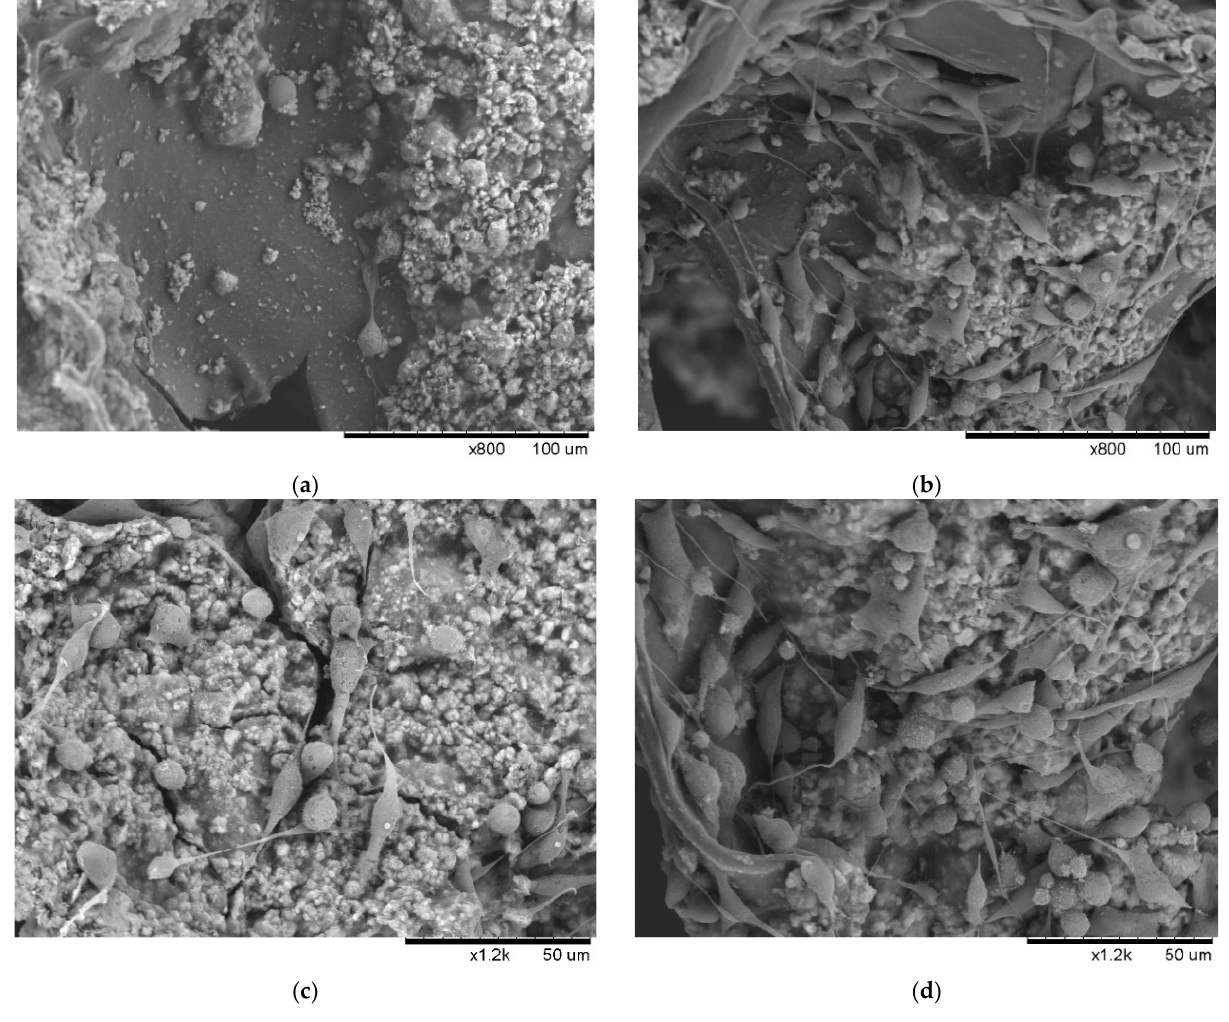
Figure 4. HAp and EGF promoted the adhesion and proliferation of MDA-MB-231: ( a ) on the third day of culture, only a small number of cells were observed to adhere to the smooth surface (gelatin) without EGF; ( b ) cell proliferation for EGF immobilized on the smooth surface (gelatin); ( c ) adhesion of many cells was observed on the rough surface (HAp) under the same conditions; ( d ) mass proliferation of adhered cells when EGF was immobilized on the rough surface (HAp). (Scale bar: 50 µ m) (The “ × ” in scale bar in the figure represents